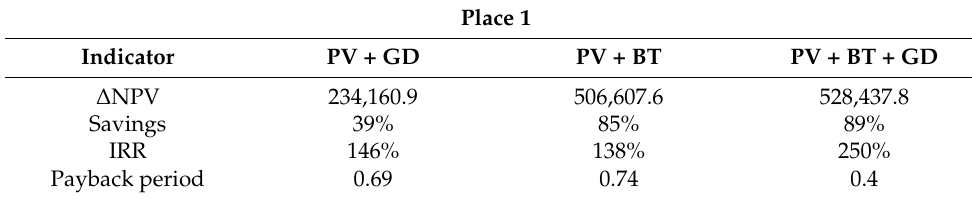
Table 5. Economic indicators influenced by the irradiation level and system configuration, Calama.